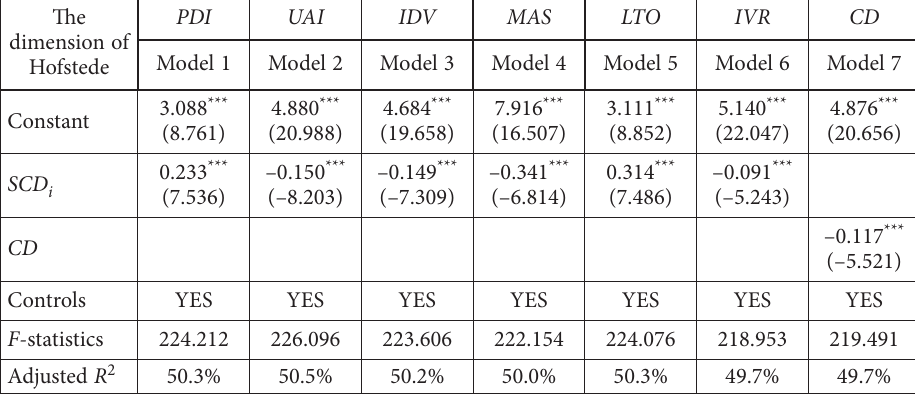
Table 4. Regression results of additional analysis (source: authors’ calculation) The dimension of